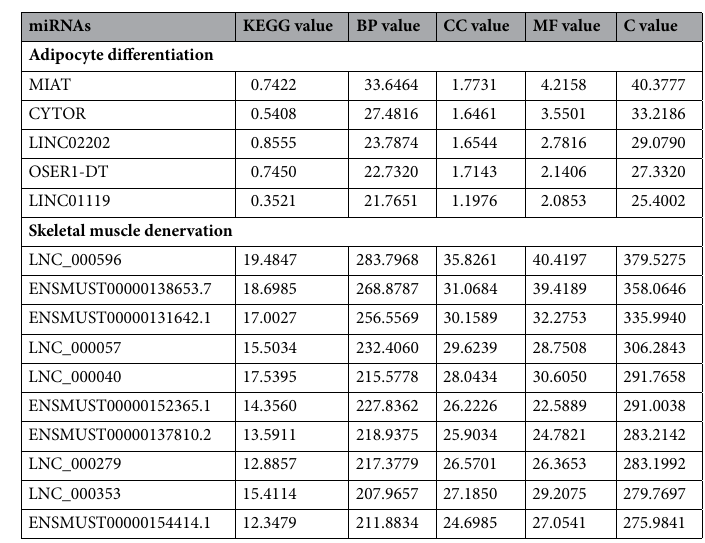
Table 3. The top lncRNAs according to C value. BP , biological process; CC , cellular component; MF , molecular function.